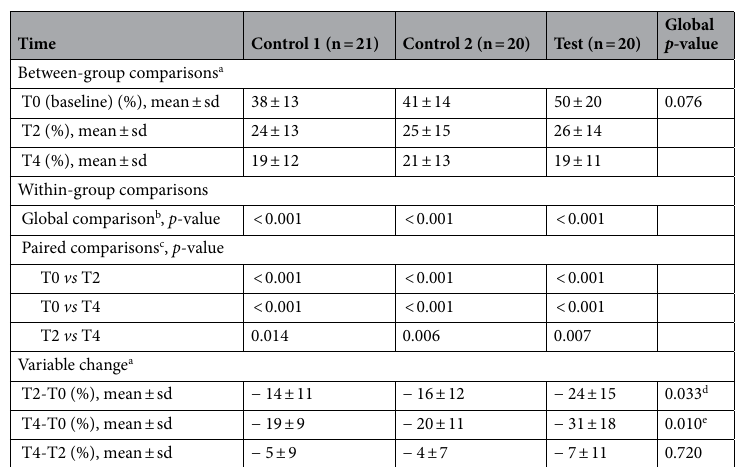
Table 3. Plaque index results over time in three study groups: baseline, 2-month, and 4-month follow-up. a ANOVA was used for between-groups and variable change comparisons (three groups). If p -value < 0.05, post- hoc paired comparisons (with Bonferroni’s method) were also performed (depicted in footnotes d and e). b For intra-group comparisons (three times), Friedman’s test was used. c Student’s T-test for paired samples. d post- hoc paired comparisons for independent groups: Significant difference between Test and Control 1 (− 10%, p = 0.047; 95%-CI = − 19, − 1). e Post-hoc paired comparisons for independent groups: Significant difference between Test and Control 1 (− 11%, p = 0.020; 95%-CI = − 21, − 1), and between Test and Control 2 (− 11% p = 0.030; 95%-CI = − 21, − 1).